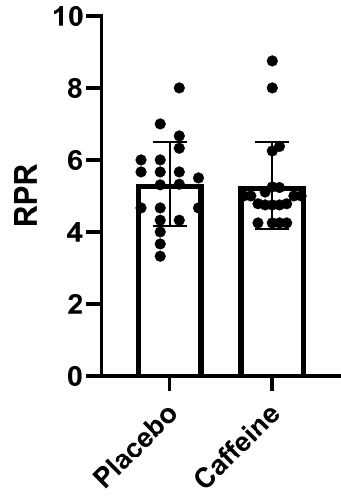
Figure 3. RPR: Caffeine vs. Placebo.